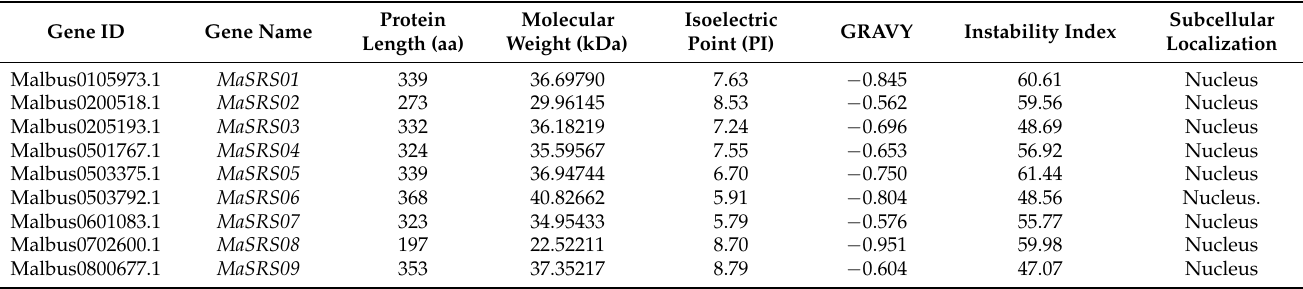
Table 1. Details of the SRS gene family members identified in M. albus